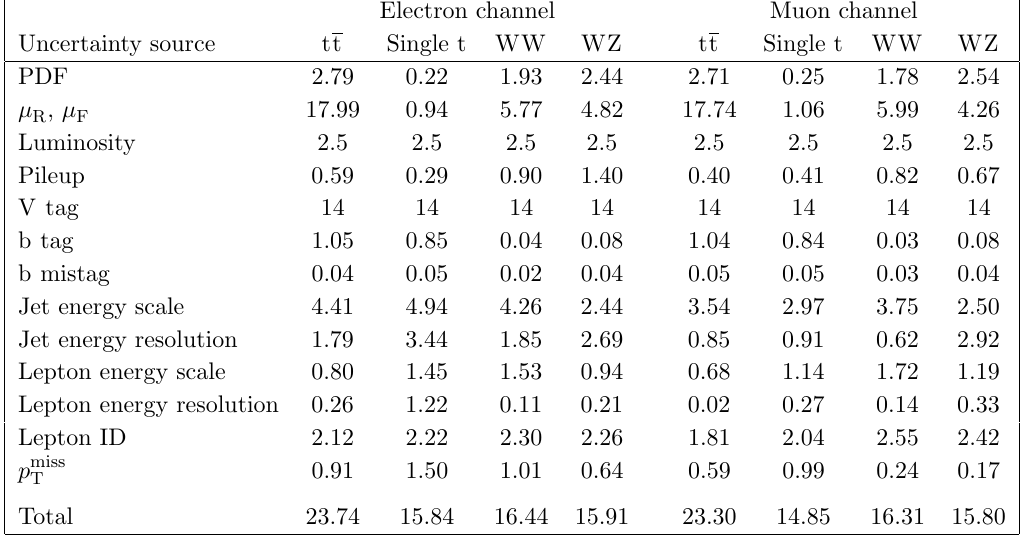
Table 2 . Estimated normalization uncertainties (%) for SM background contributions derived from